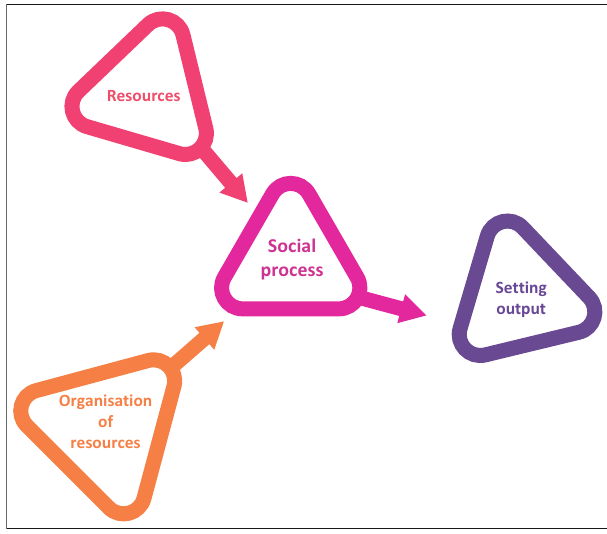
FIGURE 1 : Conceptual framework for understanding social